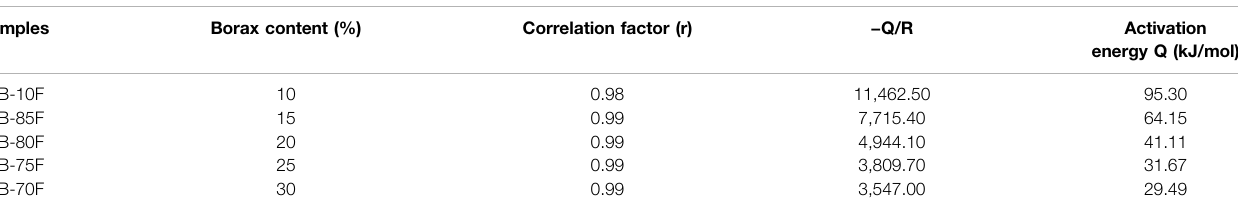
TABLE 3 | Activation energy of sintering samples with different borax additions.